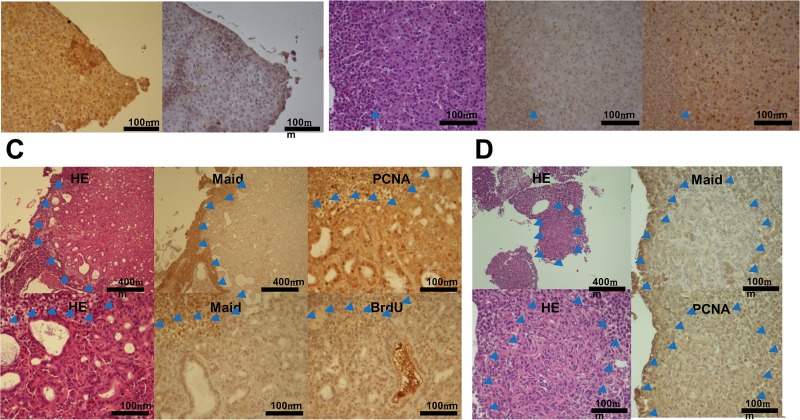
Immunohistochemical analysis of Maid expression during chemical carcinogenesis in zebrafish.(A) Liver samples from zebrafish that had been treated for 8 weeks with DEN and subsequently developed preneoplastic foci were subjected to immunohistochemical staining. Results are representative of 11 preneoplastic foci. Red arrow heads indicates Maid overexpressed lesion. Blue arrow heads indicate boundaries of tumor lesions. (B) Liver samples from zebrafish exhibiting HCC after 8 weeks of DEN treatment were subjected toimmunohistochemical staining. Results are representative of 15 HCCs. Blue arrow heads indicate boundaries of tumor lesions. (C) Liver samples from zebrafish exhibiting cholangiocarcinoma after 8 weeks of DEN treatment were subjected to immunohistochemical staining. Results are representative of 4 cholangiocarcinomas. Blue arrow heads indicate boundaries of tumor lesions. (D) Liver samples from zebrafish exhibiting mixed tumors after 8 weeks of DEN treatment were subjected to immunohistochemical staining. Results are representative of 21 mixed tumors. Blue arrow heads indicate boundaries of tumor lesions.